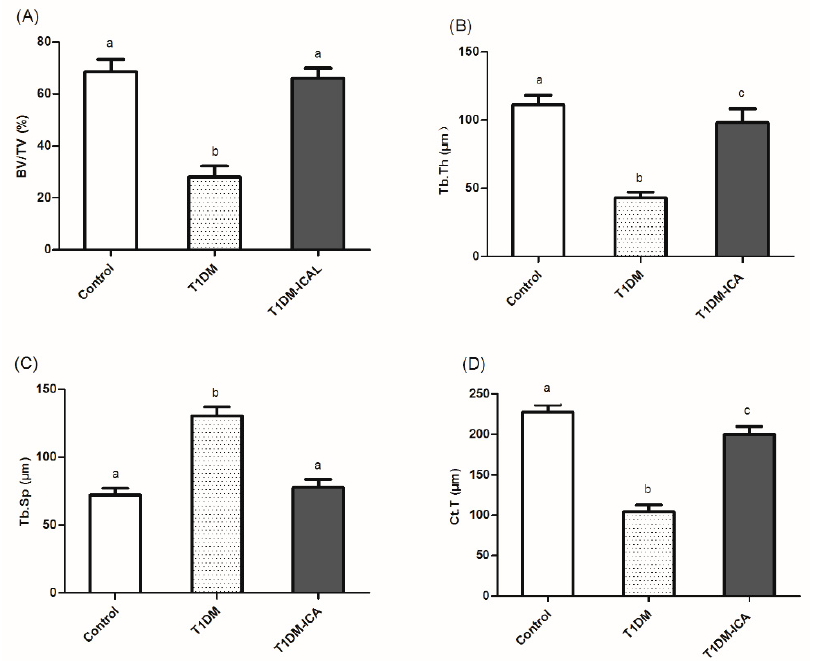
Figure 4. Bone histomorphometric parameters in all experimental groups. ( A ) Bone volume per tissue volume (BV/TV, %); ( B ) trabecular thickness (Tb.Th, μ m); ( C ) trabecular separation (Tb.Sp, μ m); ( D ) cortical thickness (Ct.T, μ m). Values are presented as means ± SD. Different letters indicate statistically significant difference ( p < 0.05).